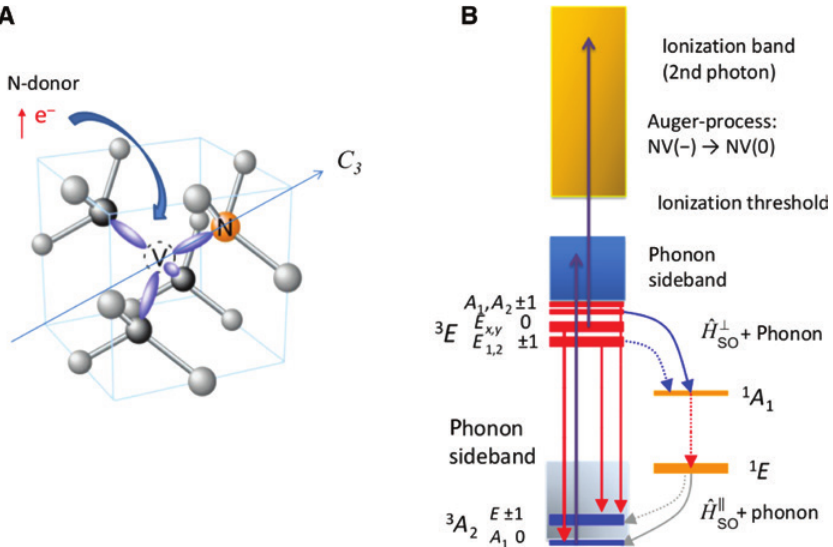
Figure 1: (A) NV defect in diamond. Vacancy is depicted as a circle in the middle of the diamond cage (gray balls are carbon atoms). An electron is provided by the diamond environment, e.g. N-donor, which creates the negatively charged NV defect, i.e. NV(–), briefly NV center. Three carbon atoms and the nitrogen atom have dangling bonds pointing toward the vacancies. The defect has a threefold rotation axis ( C ) 3 about the ⟨111⟩ axis of diamond. The eigenstates of the NV center can be labeled by C symmetry irreducible representations. (B) Electronic 3 v structure and decay processes. The double group representations for the triplet states are also depicted with their corresponding spin eigenstates. Red arrows represent emission (weak between singlets). Curved arrows show the ISC processes that are mediated by phonons ˆ( ), H where the dominant components are shown with solid lines. and the parallel or perpendicular components of spin-orbit interaction SO Dark gray arrows show the absorption that may lead to the ionization of the NV center. Note that hyperfine interaction occurs between the electron spin and the nitrogen nuclear spin (not